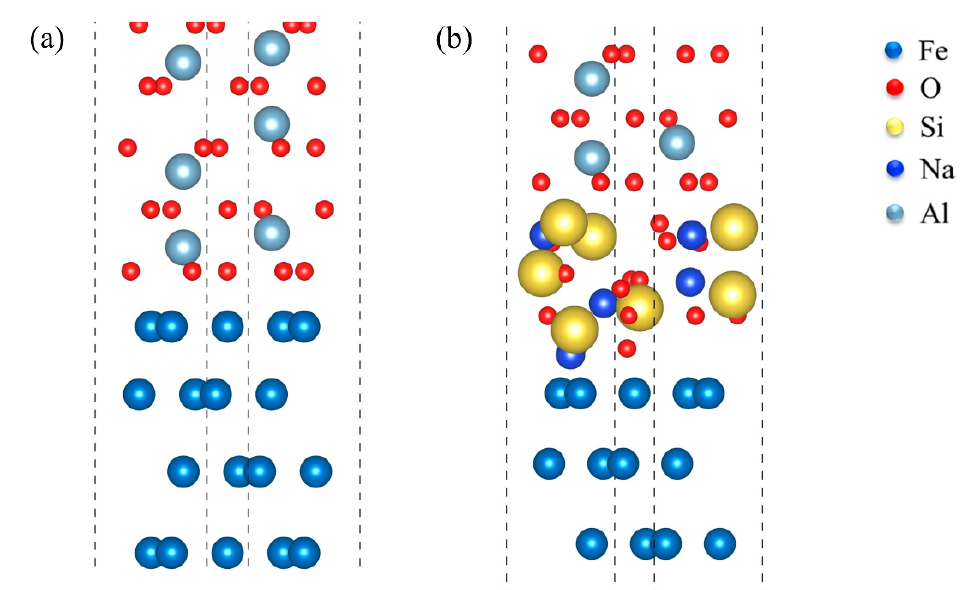
Figure 7. The geometrical structure of the ( a ) Fe-Al 2 O 3 and the ( b ) Fe-amorphous Na 2 SiO 3 -Al 2 O 3 interfaces.